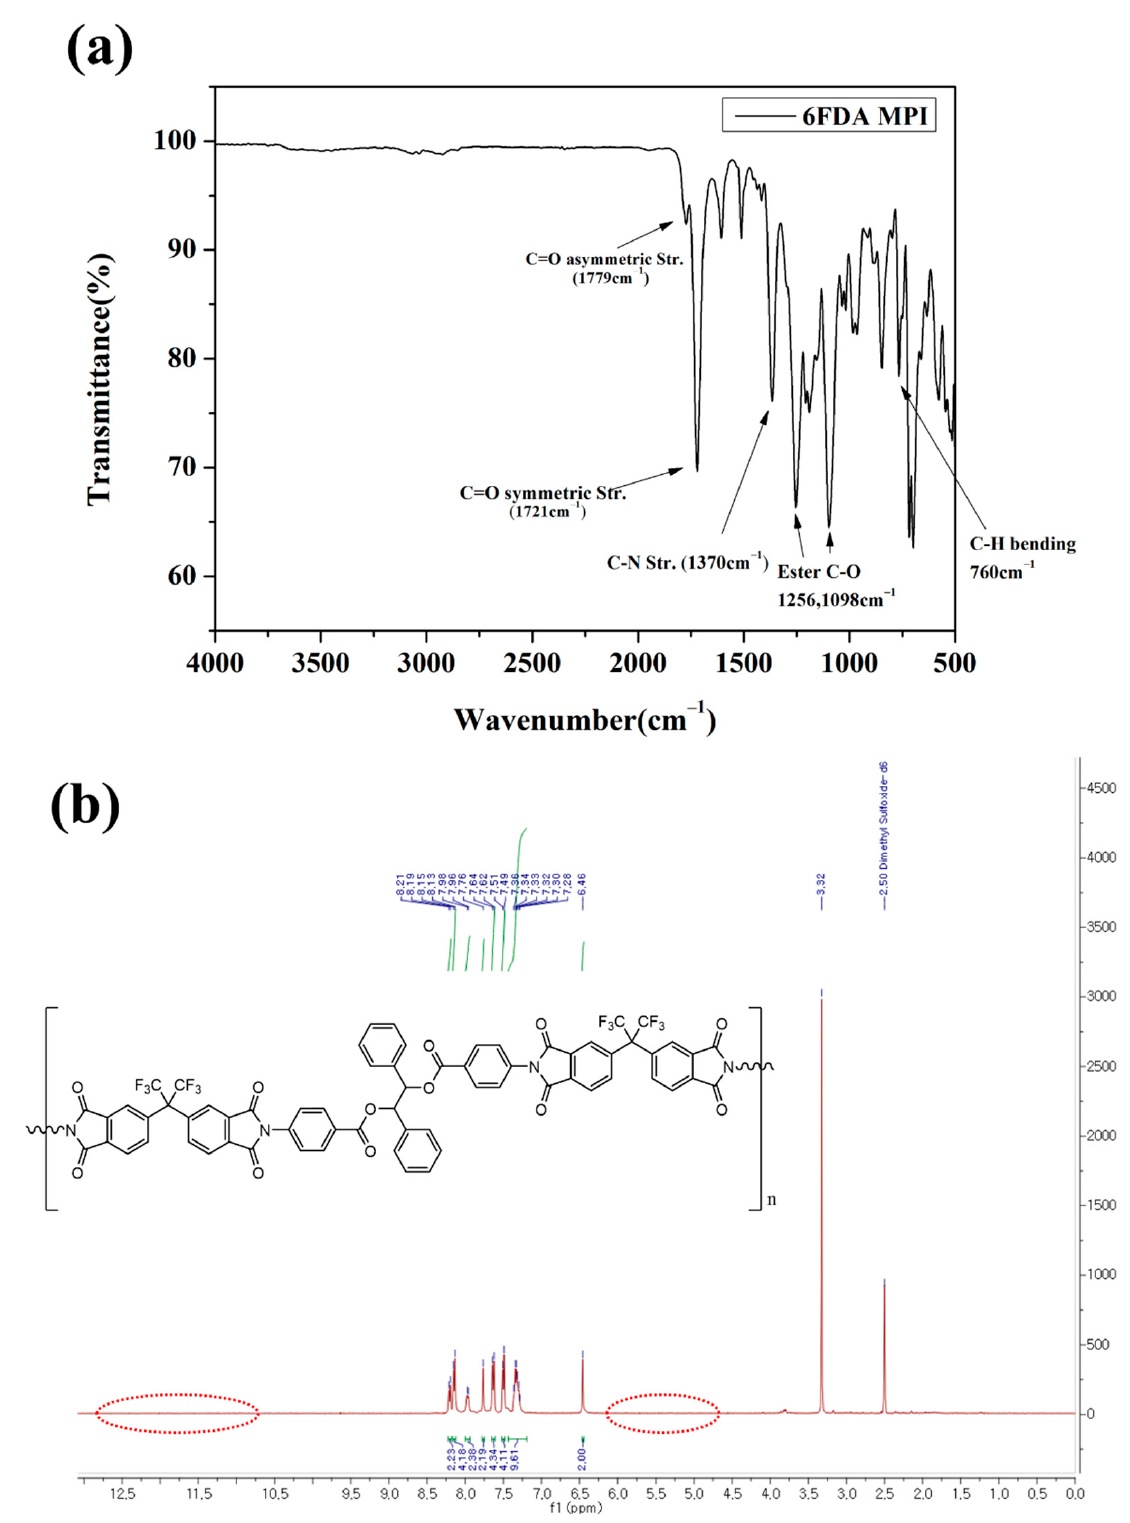
Figure 5. FT-IR spectrum ( a ) and 1 H-NMR spectrum ( b ) of 6FDA-DPEDBA PI powder.